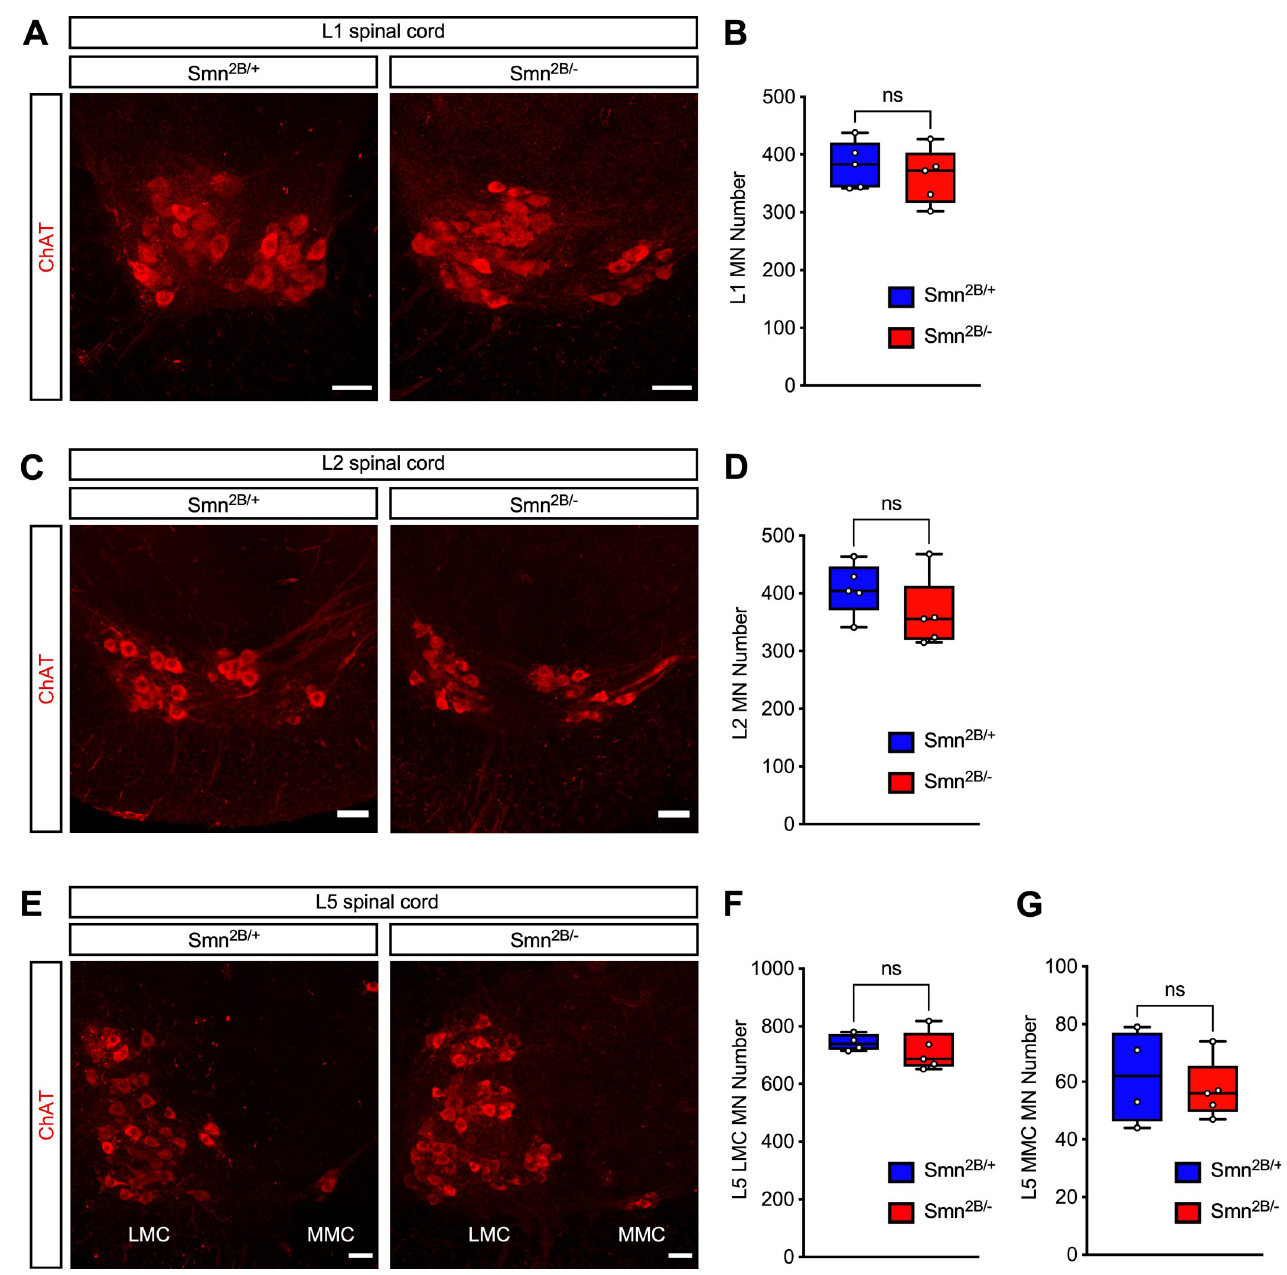
Fig 4. Death of lumbar motor neurons is not a disease feature of Smn 2B/- SMA mice. (A) ChAT immunostaining of motor neurons in the L1 spinal segment from control ( Smn 2B/+ ) and SMA ( Smn 2B/- ) mice at P16. Scale bars: 50 μ m. (B) Total number of L1 motor neurons from the same groups as in (A). The box- and-whiskers graph shows the individual values, median, interquartile range, minimum and maximum from 5 mice per group. Statistics were performed with two-tailed unpaired Student’s t-test. ns = not significant. (C) ChAT immunostaining of motor neurons in the L2 spinal segment from control ( Smn 2B/+ ) and SMA ( Smn 2B/- ) mice at P16. Scale bars: 50 μ m. (D) Total number of L2 motor neurons from the same groups as in (C). The box-and-whiskers graph shows the individual values, median, interquartile range, minimum and maximum from 5 mice per group. Statistics were performed with two-tailed unpaired Student’s t- test. ns = not significant. (E) ChAT immunostaining of motor neurons in the L5 spinal segment from control ( Smn 2B/+ ) and SMA ( Smn 2B/- ) mice at P16. Scale bars: 50 μ m. (F and G) Total number of L5 LMC (F) and L5 MMC (G) motor neurons from the same groups as in (E). The box-and-whiskers graph shows the individual values, median, interquartile range, minimum and maximum from Smn 2B/+ (n = 4) and Smn 2B/- (n = 5) mice. Statistics were performed with two- tailed unpaired Student’s t-test. ns = not significant.